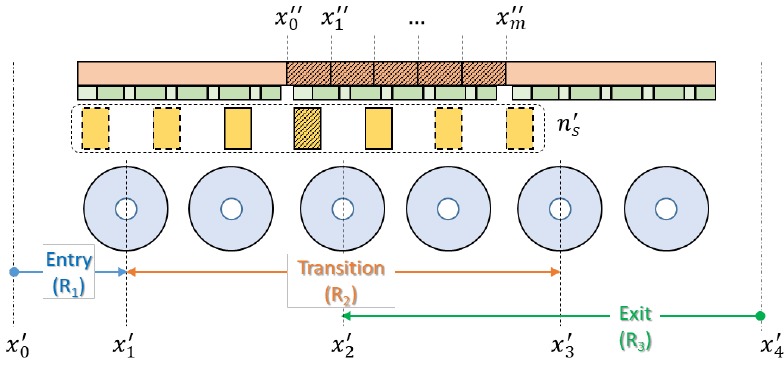
Figure 9. Geometric model adopted for the simplified transient FEAs with the position ranges x (cid:48)